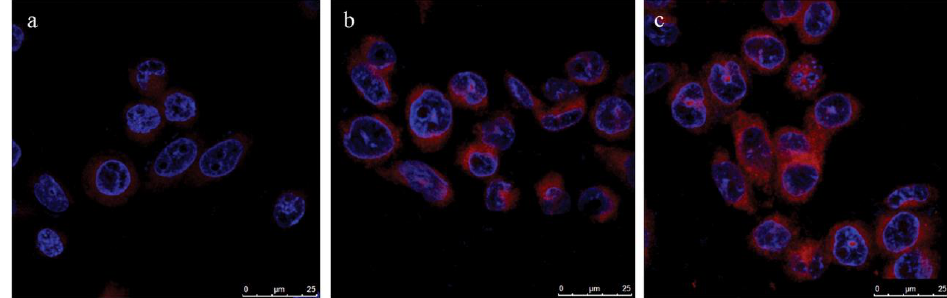
Figure 5. Cellular uptake of ( a ) free PS, ( b ) Fe 3 O 4 -Au-LA-PS (MGPS) and ( c ) Affibody -MGPS.by SK-OV-3 cells. Reprinted with permission from reference [67] . Copyright 2014 Elsevier.